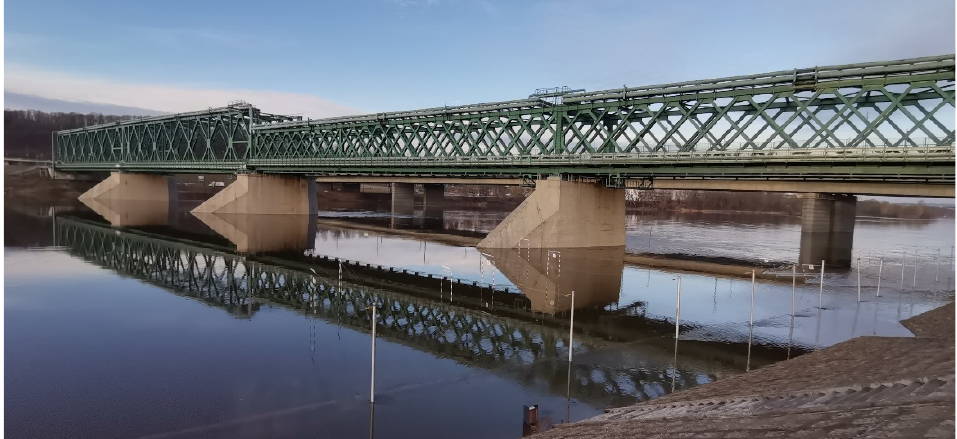
Figure 2. Study object: Kaunas Railway Bridge (source: R. Baubly s).